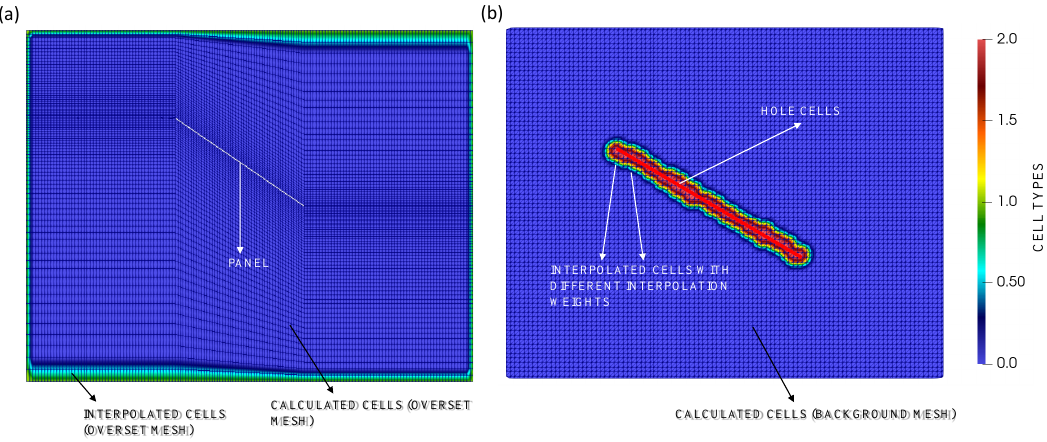
Figure 4. Identification of cells by overset solver ( a , b ). The cell types depict how interpolation weights vary based on their distance from the hole points, as depicted in ( b